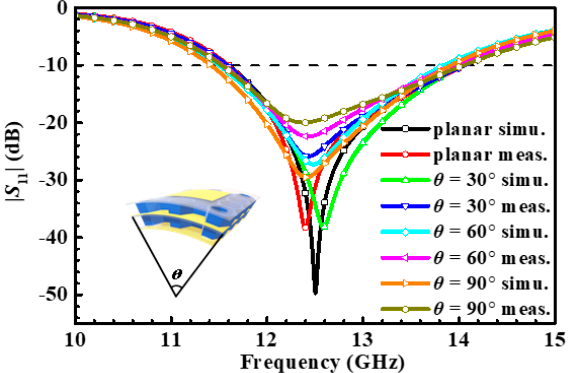
Figure 12. Simulated and measured reflection coefficient results of proposed antenna element under various bending states and on the plane. The inset illustrated the bending state.